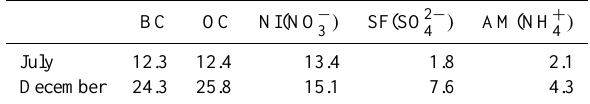
Table 5. The VECs of chemical components in PM 2 . 5 in the urban Beijing region